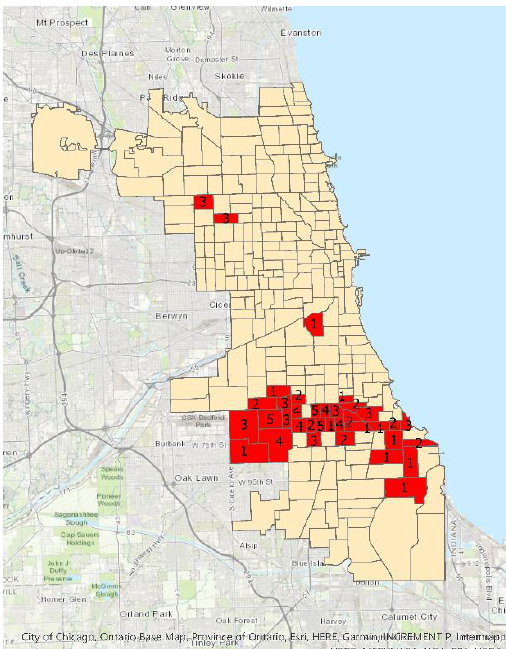
Figure 14. High value clusters by 2-hour interval in a day at police beat